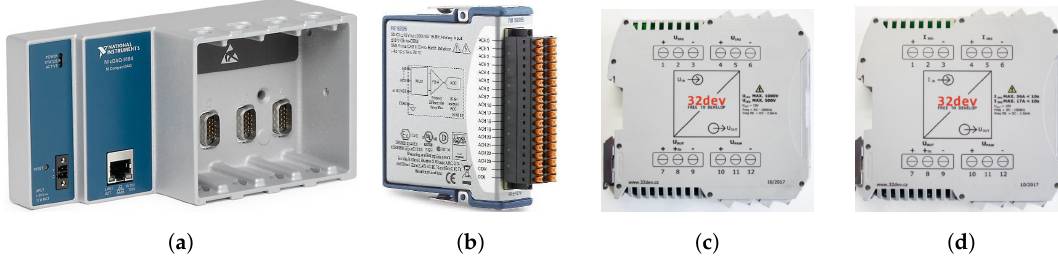
Figure 9. Power quality (PQ) system components: ( a ) NI cDAQ 9185 4-slot chassis, ( b ) NI-9205 data acquisition module, ( c ) voltage converter, and ( d ) current